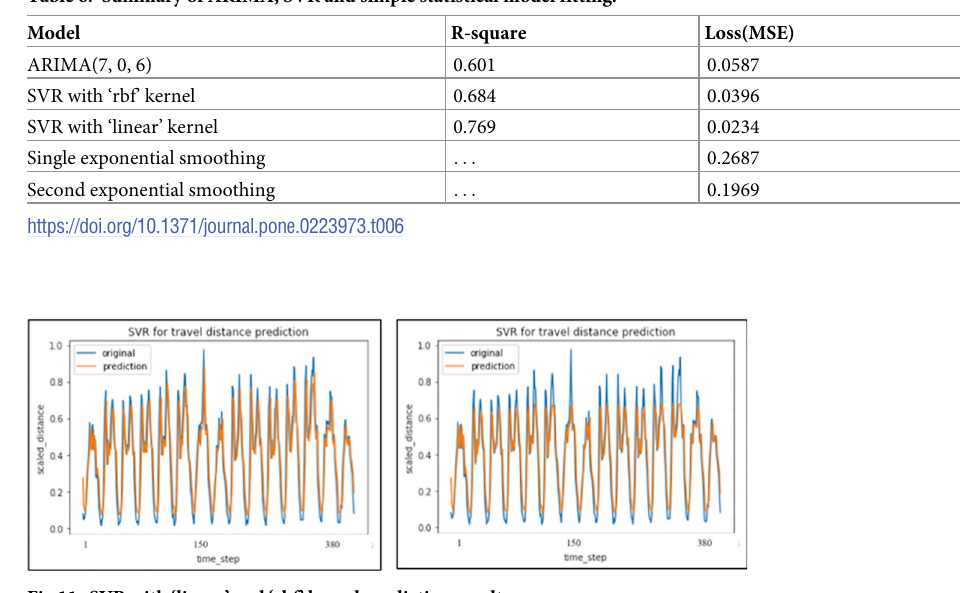
Fig 11. SVR with ‘linear’ and ‘rbf’ kernel prediction results.